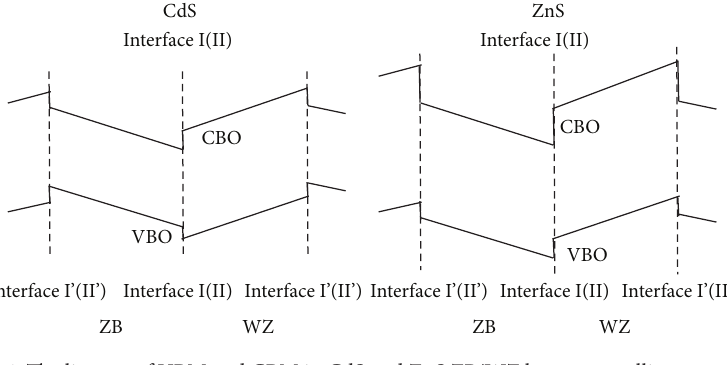
Figure 4: The lineups of VBM and CBM in CdS and ZnS ZB/WZ heterocrystalline